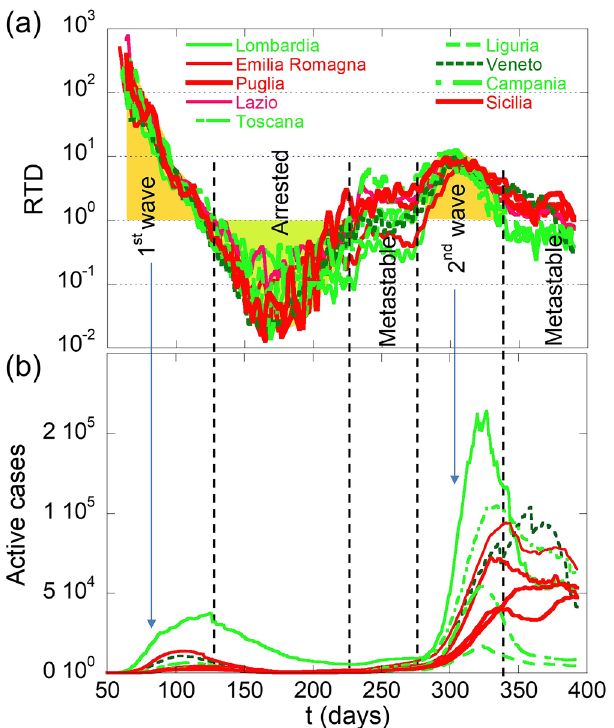
Figure 4. ( a ) RTD vs. time for the Italian regions. The two pandemic waves are described by the two yellow areas among dashed vertical lines where RTD > 1. The green area [RTD < 1] outlines the arrested phase where R t < 1 and T d > 100. We can distinguish the first metastable phases and the precursors of the second pandemic wave while the second metastable phase is in full swing. In these phases, RTD fluctuates around 1 for a finite time. ( b ) The cumulative curve of the active cases per millions of populations. We observe the increase during the pandemic waves as well as the decrease in the arrested phase and the almost flat behavior in the metastable phases.